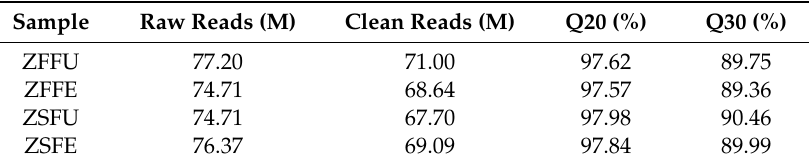
Table 1. Overview of reads filtering and quality in four libraries.